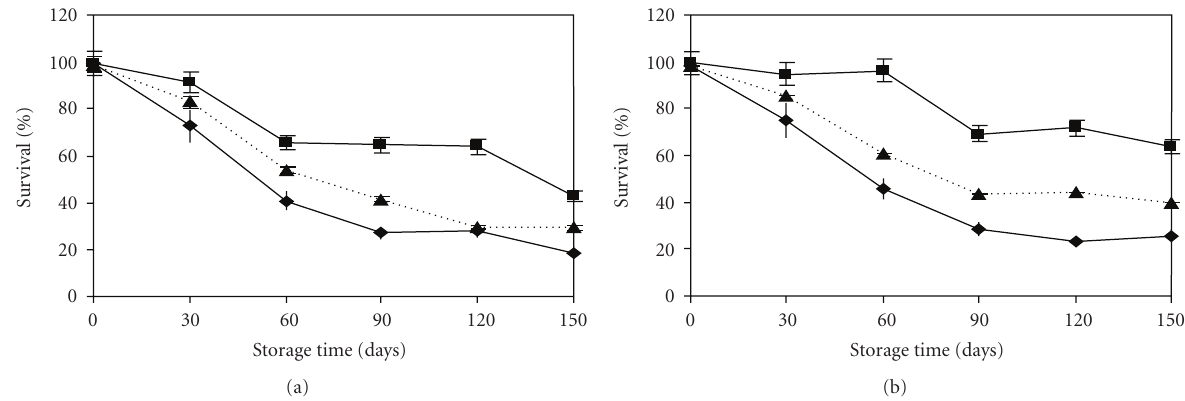
Figure 3: Survival of freeze-dried lactobacilli during 120 d at room temperature in the vacuum seal bags. Values are presented as means ± standard deviation (SD, n = 4). (a) L. paracasei ssp . paracasei LMG 9192 T , (b) L. plantarum CWBI-B1419 T and (c) control (— (cid:4)